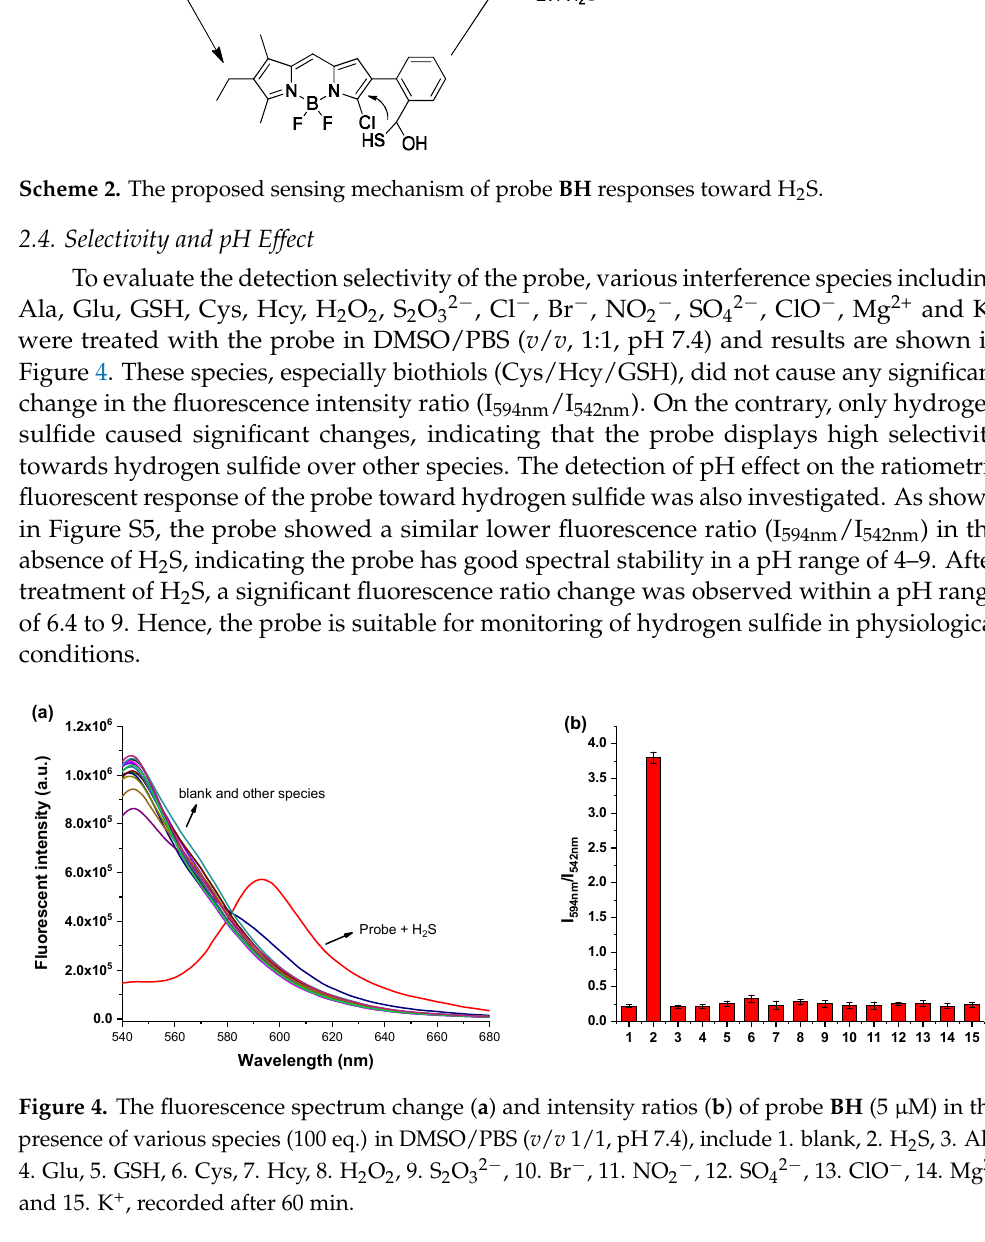
Figure 5. Cell viability values (%) estimated by an MTT assay versus incubation concentrations of CT26 cells were cultured in the presence of probe (0–50 μM) at 37 °C for 48 h.